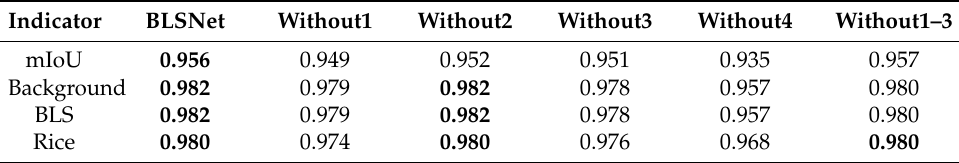
Table 3. Accuracy comparison in ablation study when removing attention